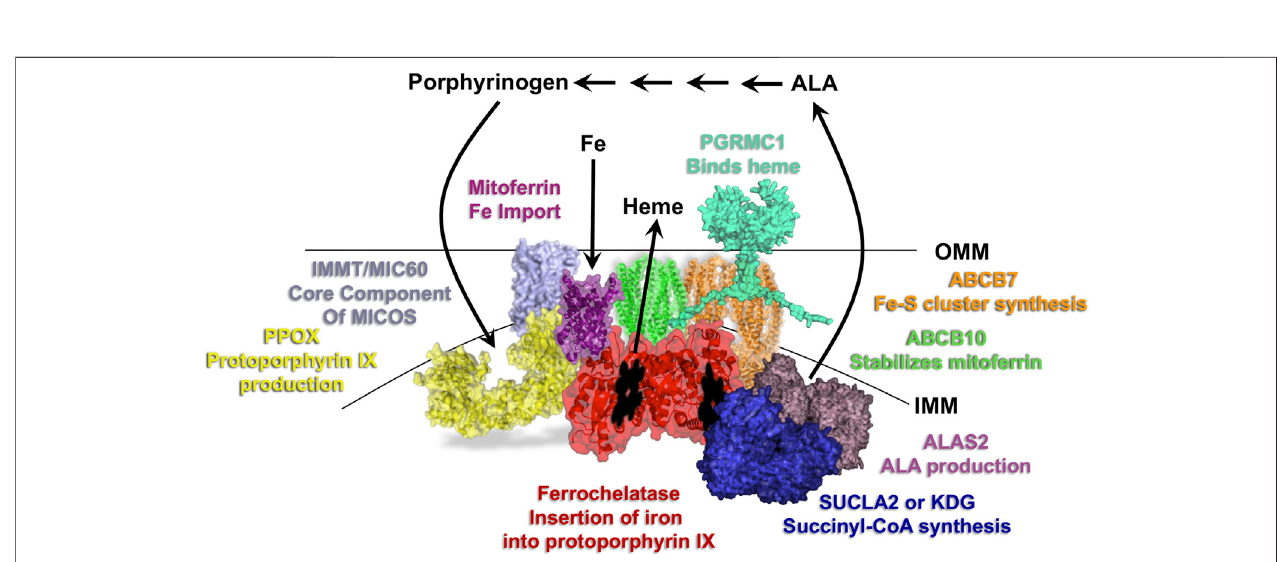
FIGURE2| Overviewofthehemesynthesispathwayandmodelofkeymitochondrialmetaboloncomponents.Localizationofthe fi rstandlastthreereactionsofthe heme synthesispathway occur inthemitochondria, withthose inbetween occurring in thecytosol.Selectproteins ofthemitochondrial heme metabolon areshown and labeled with their roles in porphyrin, iron and heme homeostasis. IMM refers to the inner mitochondrial membrane and OMM to the outer mitochondrial membrane.